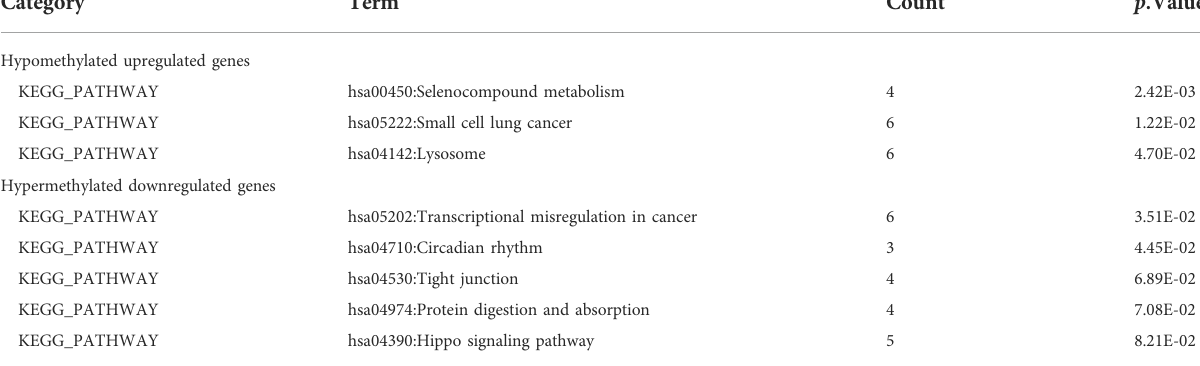
TABLE 3 Pathway enrichment analysis of